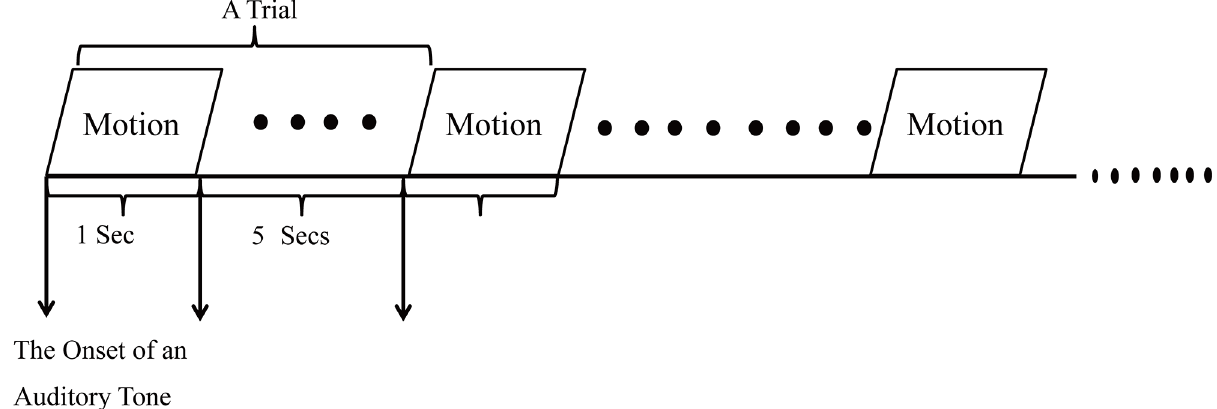
Fig 2. The experiment protocol for EMG data collection in terms of standing-sitting and walking